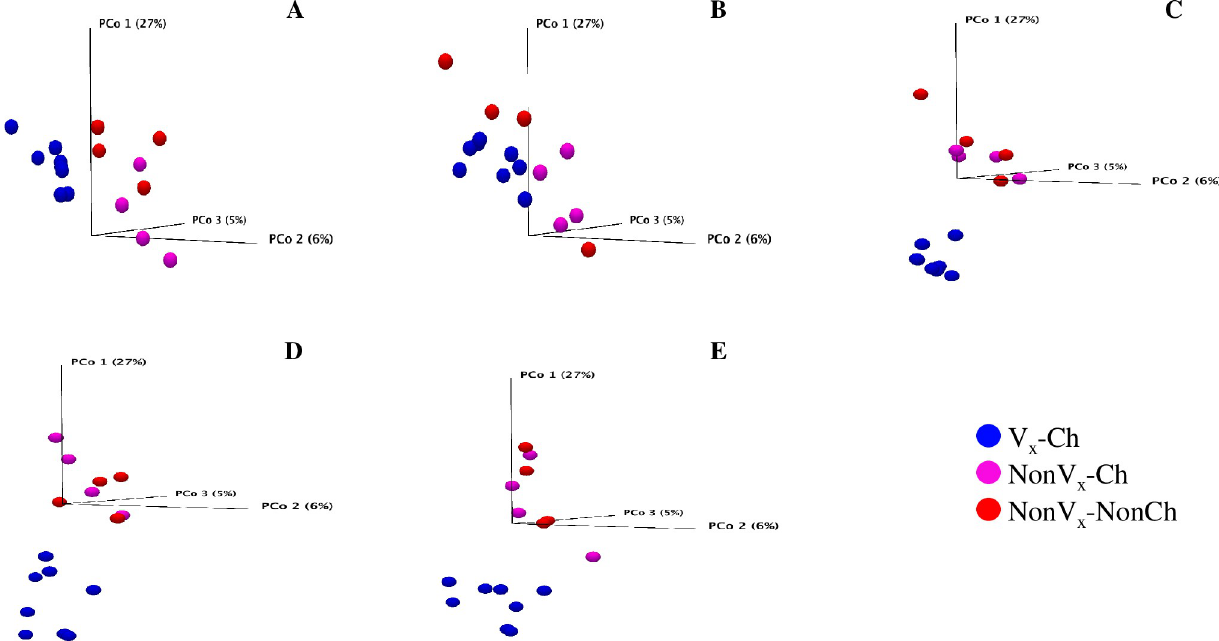
Fig 2. Principal Coordinate Analysis (PCoA) plots comparing bacterial diversity (Beta-diversity) in vaccinated and challenged (Vx-Ch), non- vaccinated and challenged (NonVx-Ch), and non-vaccinated and non-challenged (NonVx-NonCh) calves at weeks, 7 [A], 8 [B], 9 [C], 10 [D], and 11 [E]. Fecal samples on week 7 were collected just before the oral challenge with E . coli O157:H7 was given. There was no significant difference in the fecal bacterial community structure between samples from the two vaccinated groups of calves (Vx E -Ch, Vx C -Ch) at any time point, therefore the Vx E -Ch and Vx C -Ch samples were grouped together (Vx-Ch) for the